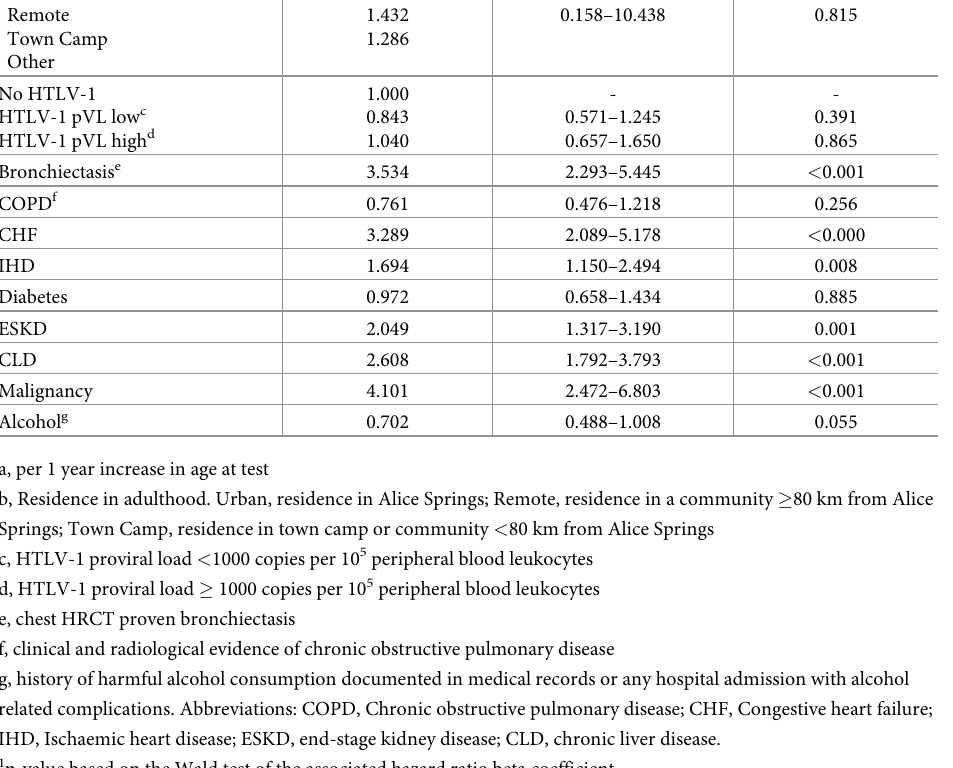
Mean (±SD) age at death for bronchiectasis-related deaths (49.5±15.3 years) was lower than that of subjects who died due to cardiovascular disease (55.0±11.5 years)(p = 0.073), sepsis (56.7±16.7)(p = 0.044) or malignancy (60.1±9.3) (p = 0.007).